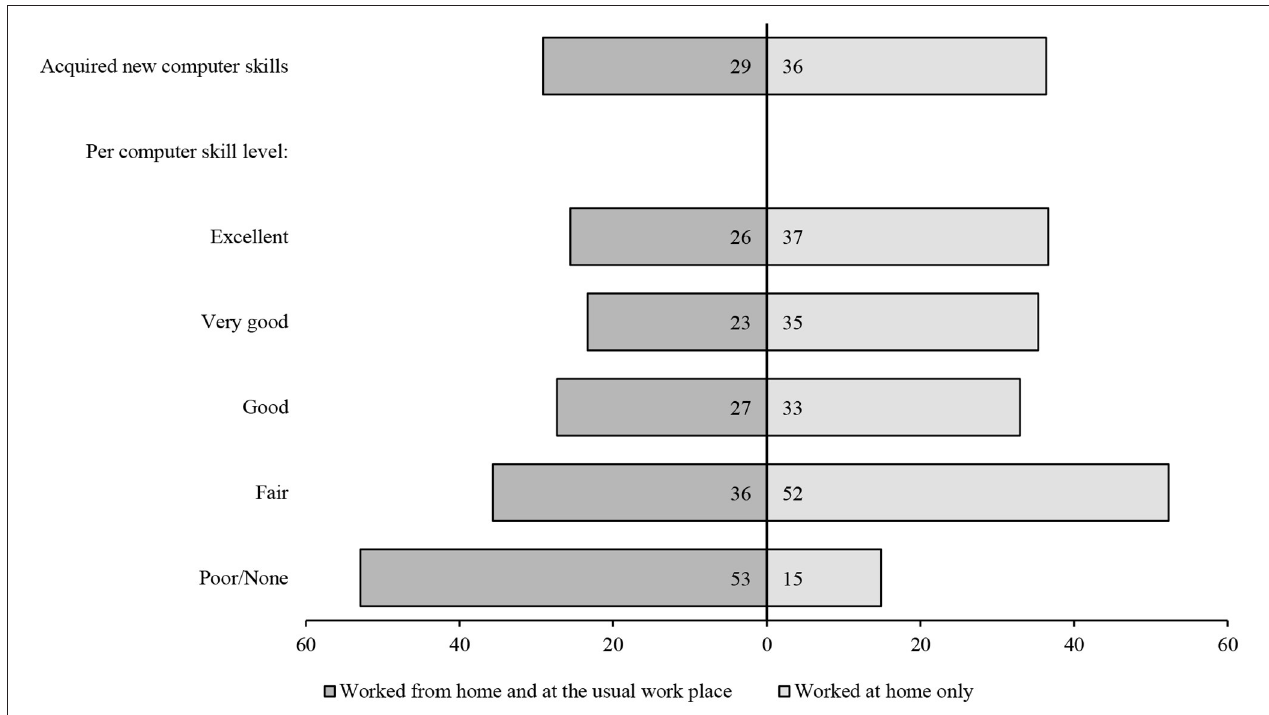
FIGURE 1 | New Computer Skills due to Home-Office in Times of Covid-19 (Proportion). Presented are proportions. Authors’ own graph. Data source: Survey of Health, Aging and Retirement in Europe (SHARE), wave 8, COVID-19 Survey 1, release 8.0.0; N = 3,197 (respondents w/o information on skill level are not shown); weighted, own